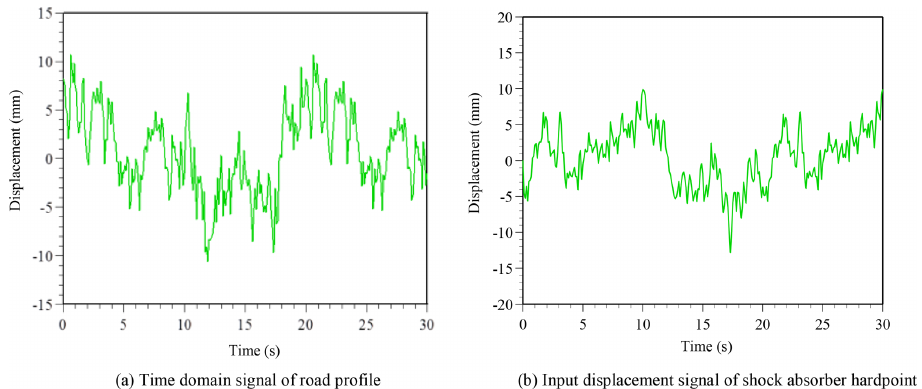
Figure 12. Road profile signal (class A) and corresponding input displacement signal to shock absorber hardpoint. (Note that vehicle velocity V is equal to 40kmh − 1 .)